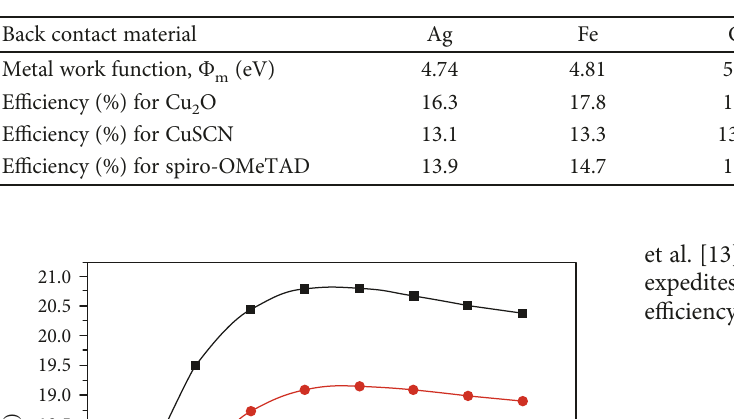
Table 4: E ff ect of di ff erent back contact.